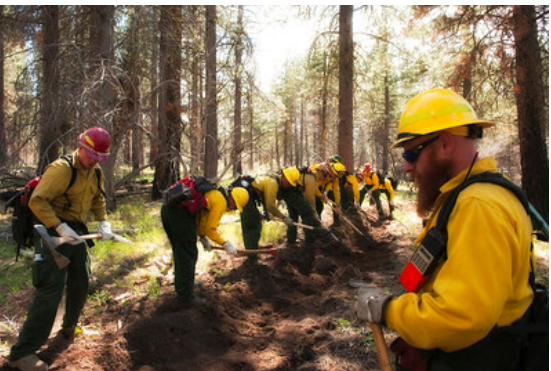
Figure 1. Example of handline construction in a forested landscape. © Bureau of Land Management Oregon and Washington, “SCOFMP Guard School 2013”, 18 June 2013, accessed from Flickr. Licensed with CC BY-SA 2.0.